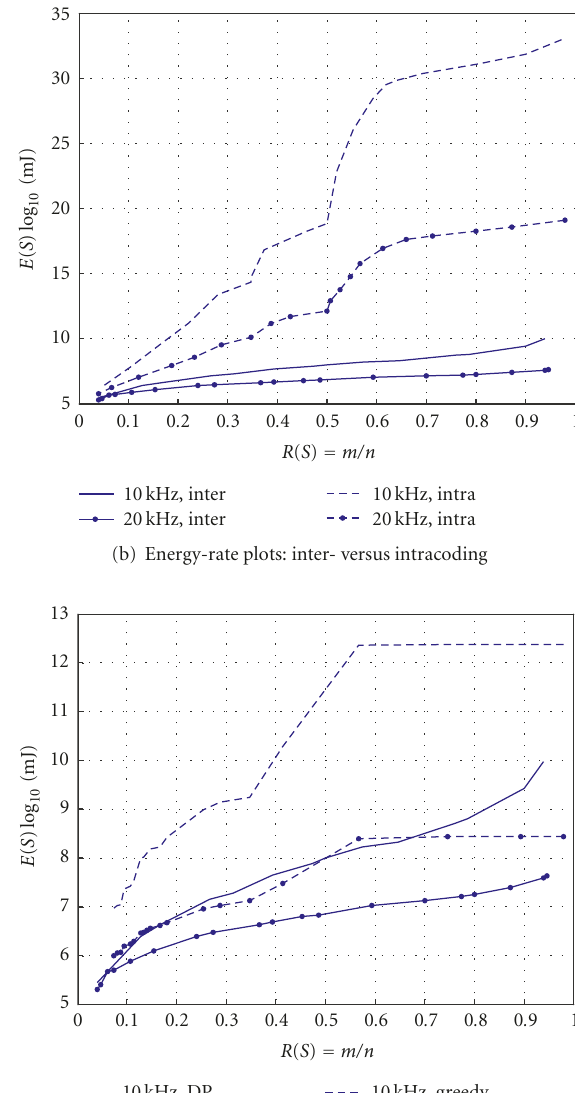
(a) Energy-distortion plots, inter- versus intracoding (b) Energy-rate plots: inter- versus intracoding